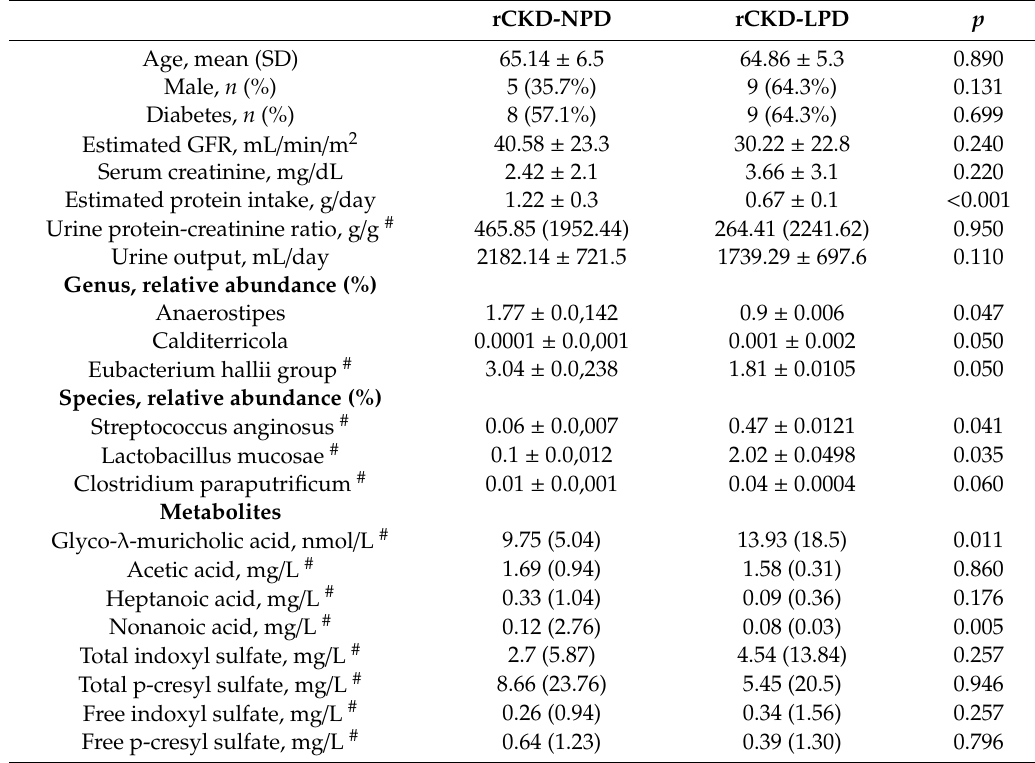
Table 4. Characteristics of resampling subset of patients with individualized match to renal function and